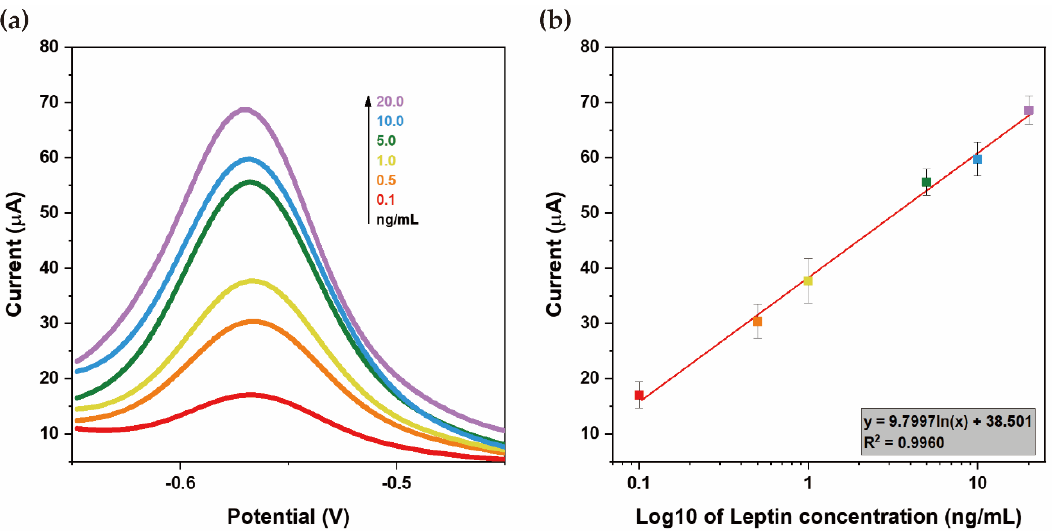
Figure 3. ( a ) Square−wave voltammetry (SWV) response curves of the biosensor toward various concentrations of leptin solutions from 0.1 to 20 ng/mL and ( b ) calibration plots displaying a robust linear relationship between the SWV peak currents and the logarithm of leptin concentrations. Each point was obtained and integrated from the peak currents in triplicate.